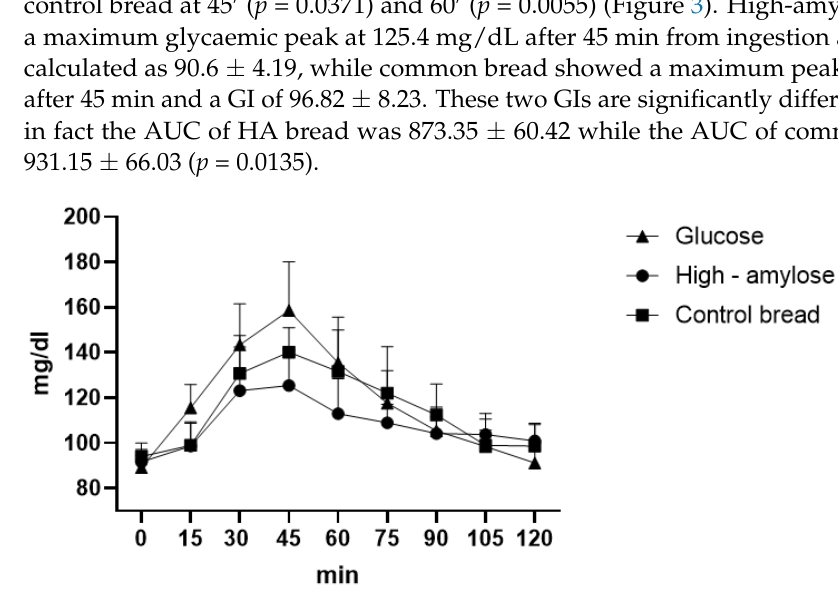
Figure 3. Bread glycaemic curve.